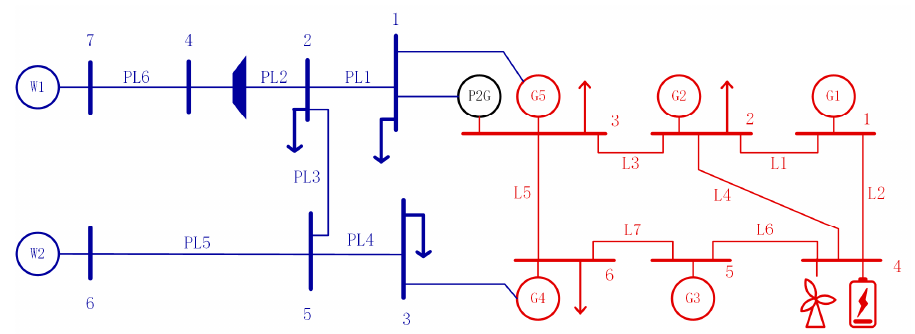
Figure 1. Topology of a 7-node NG grid with a 6-bus power grid.